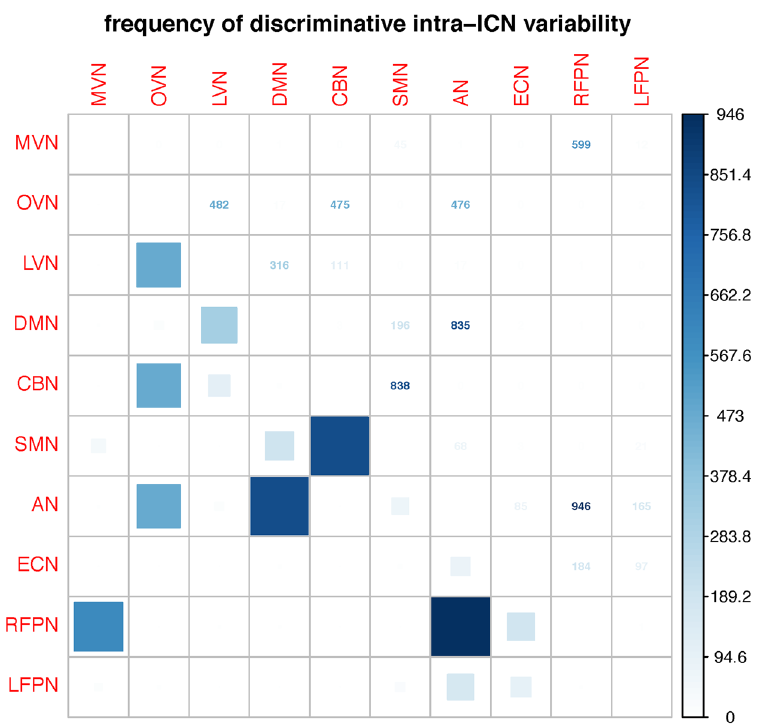
Figure 5. Frequency of discriminative patterns based on 10-folds CVs. The numbers and squares denote the frequency of top 10 discriminative patterns based on 10-folds CV.